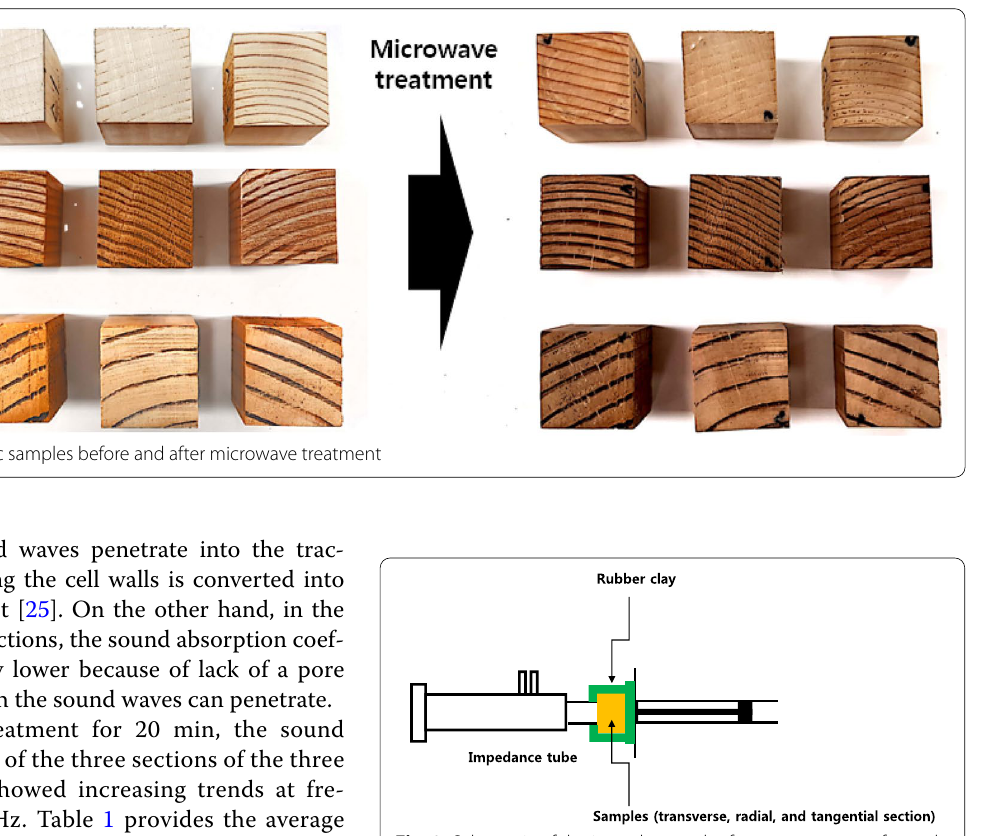
Fig. 2 Schematic of the impedance tube for measurement of sample sound absorption